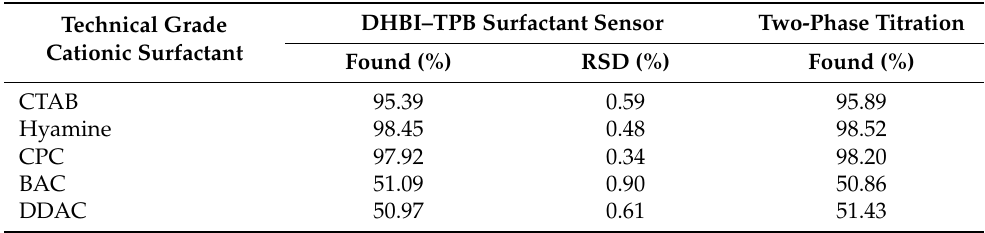
Table 3. The direct potentiometric titrations of technical-grade cationic surfactants by the DHBI–TPB surfactant sensor compared to a standard two-phase titration method. For direct potentiometric titrations, TPB (4 × 10 − 3 M) was used as a titrant.